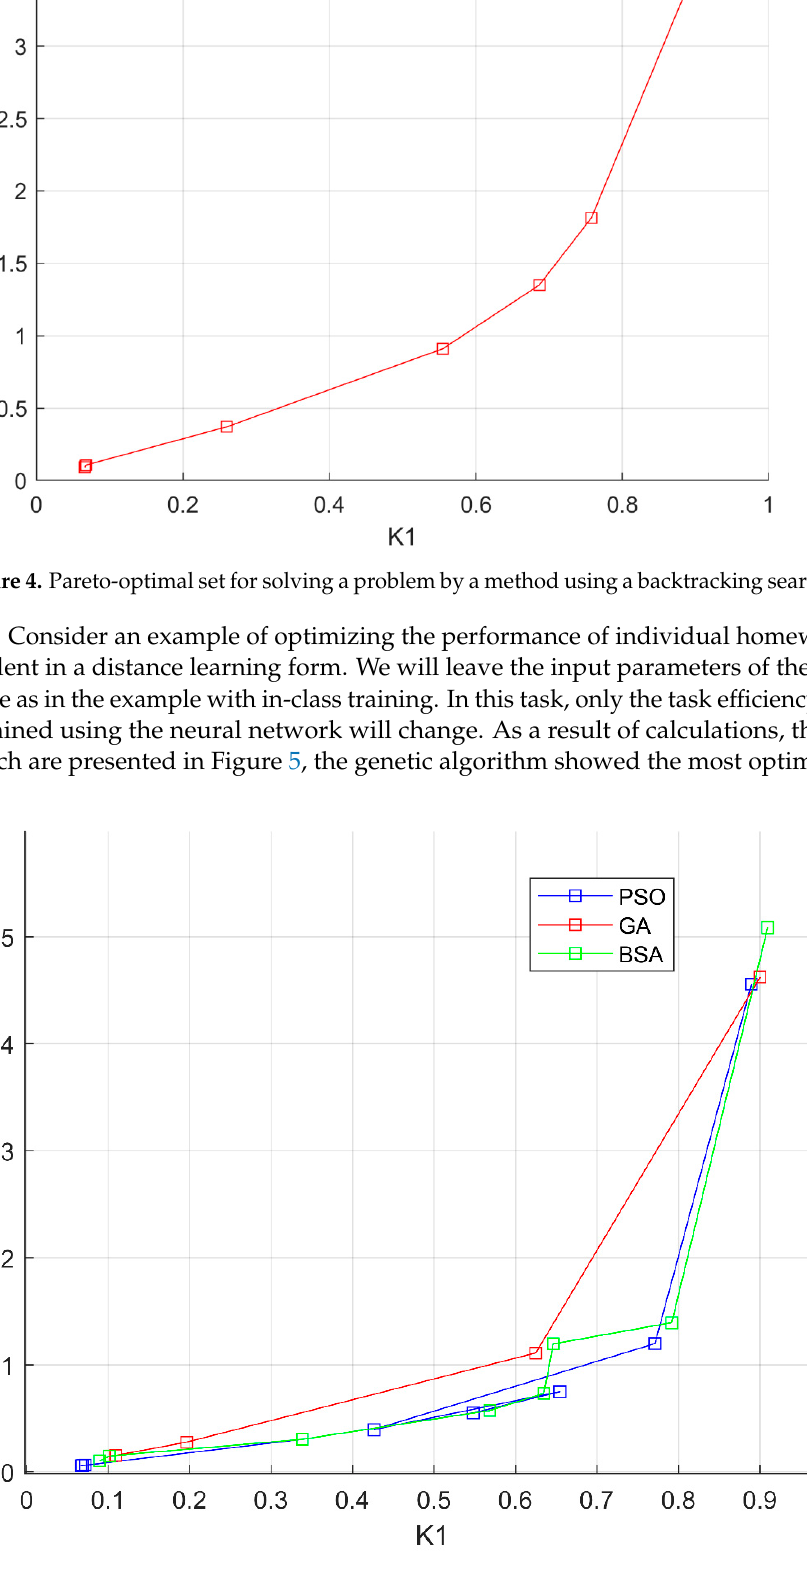
K = 0.7713, K = 1.1979, which corresponds to 21.32 min. The 1 2